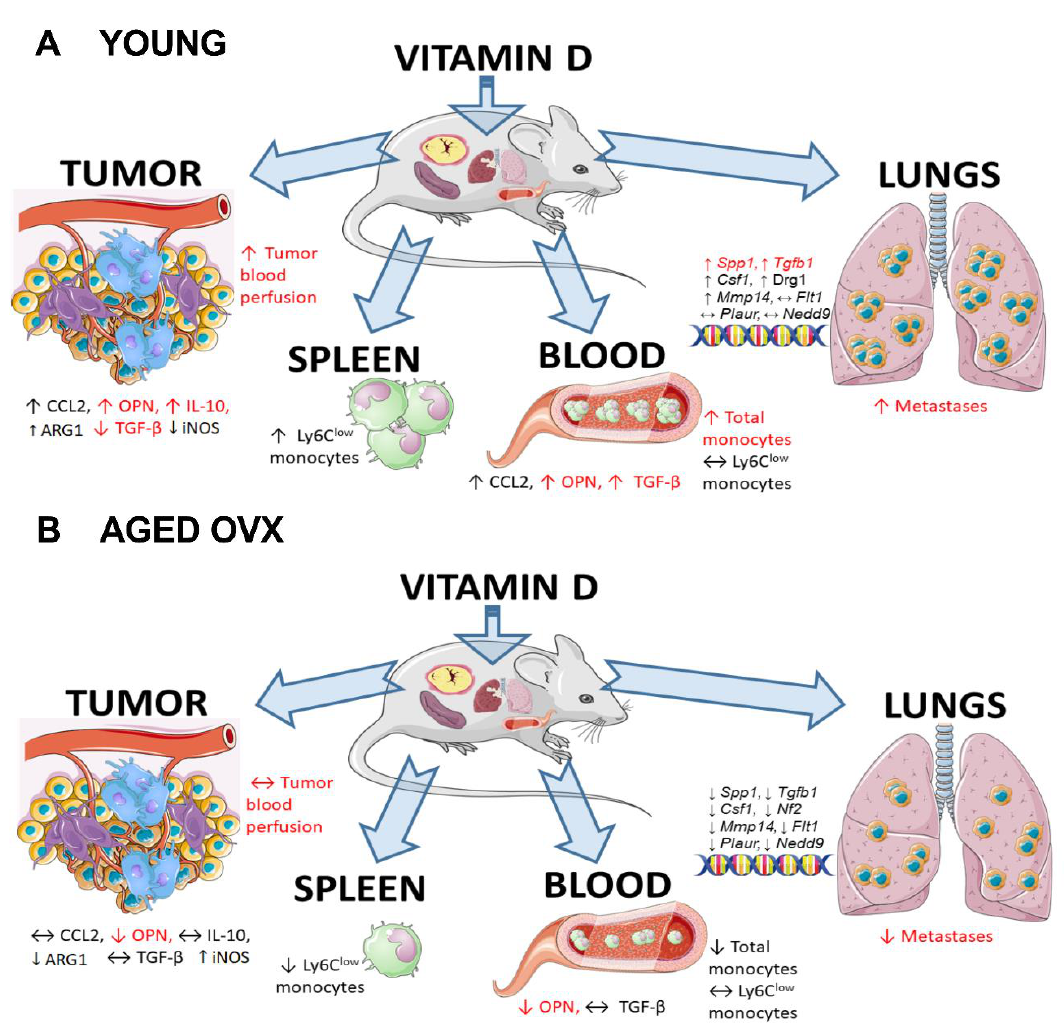
Figure 9. Vitamin D compounds effect on cancer progression in 4T1 mammary gland cancer model.